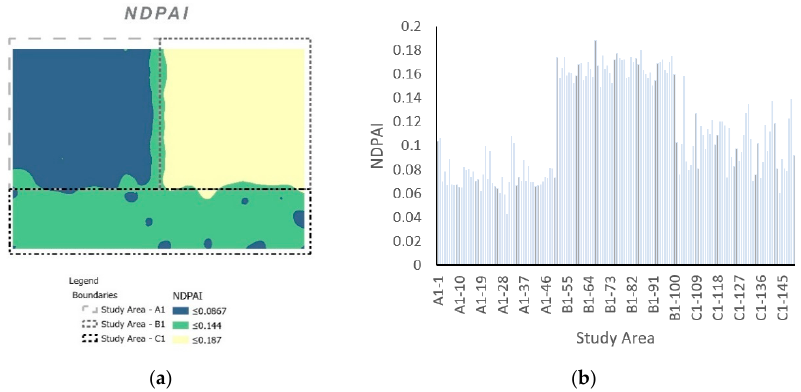
Figure 12. Use of the normalized filter (NDPAI) on the three asphalt pavement categories ( a ) and application of B6 − B1/B6 + B1 to the three pavement regions studied ( b ).